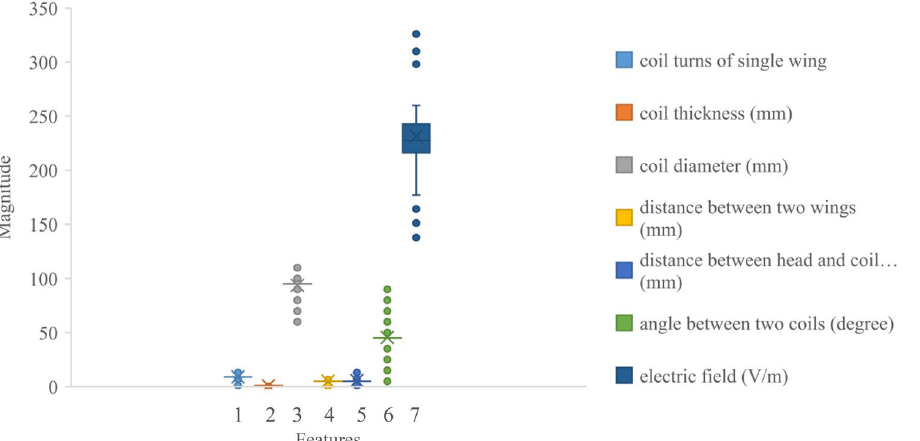
Figure 3. The boxplot of original feature